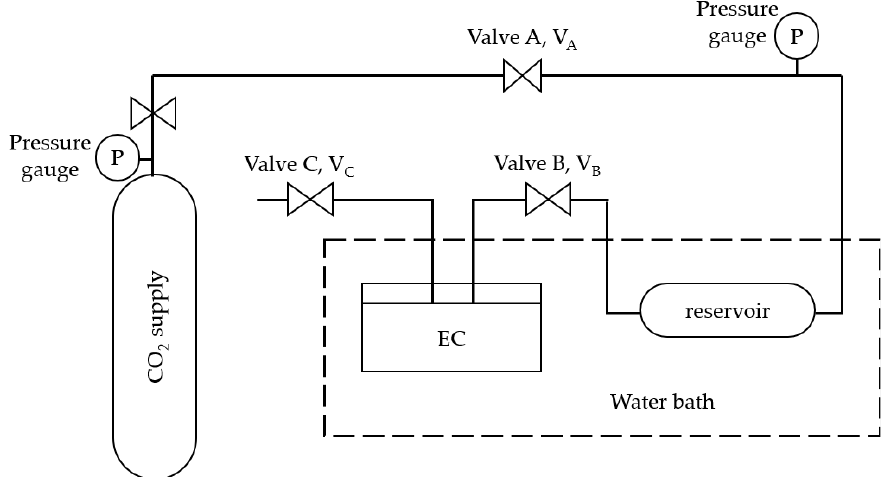
Figure 1. Schematic diagram of CO 2 absorption apparatus.